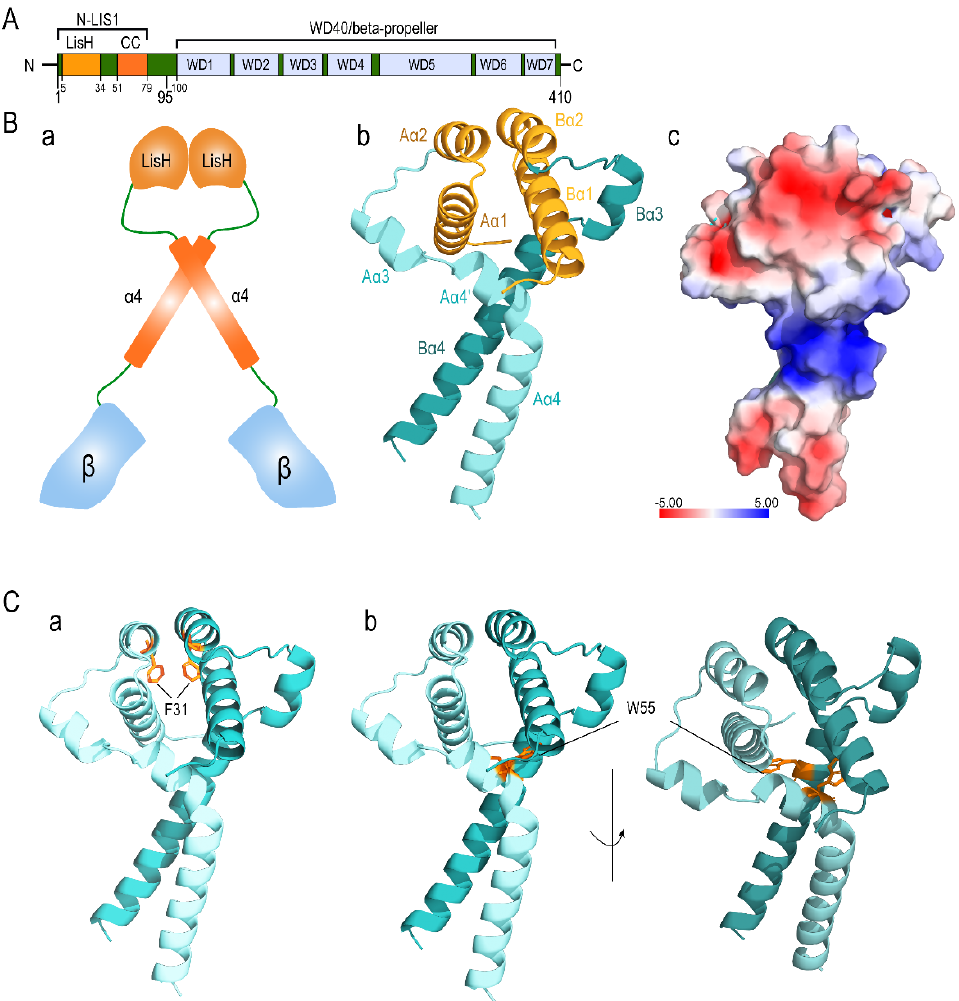
Figure 2. Domain mapping and the position of SNPs in the molecular structure of LIS1. ( A ) Domain mapping highlights the structural feature of LIS1. ( B ) Schematic depiction of LIS1 structure with domains color-coded according to panel A ( a ). Three-dimensional model of the LIS1 N-terminal region highlighting the LisH domain in orange ( b ). The electrostatic surface potential of the LIS1 N-terminal structure was obtained by using the APBS plugin of Pymol 2.5.2. The color scale is represented in kT/e ( c ). ( C ) The detected SNPs in the three-dimensional structure of wild-type LIS1 N-terminal domain are shown by the orange stick for F31 ( a ) and W55 ( b ), respectively.